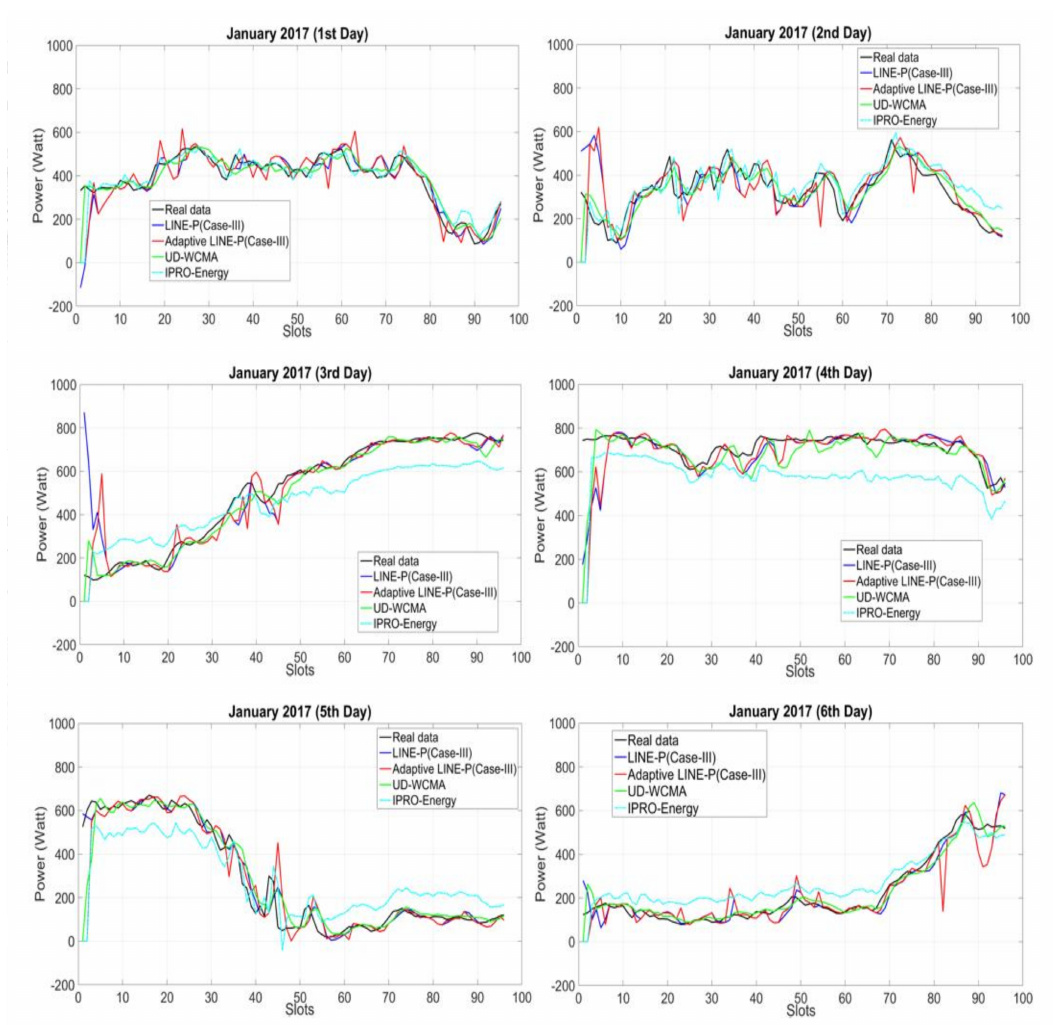
Figure 5. Graphical representation of Adaptive LINE-P (Case III) and state of the art based on the shorter (15-min data interval) time period horizon for the wind energy profile with 96 time slots in 24 h.